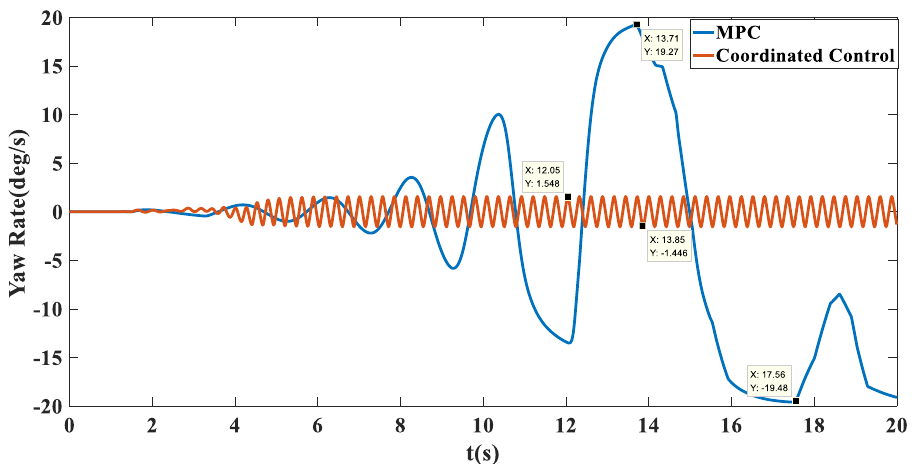
Figure 12. Transverse pendulum angular velocity tracking comparison chart on the split mu straight road.